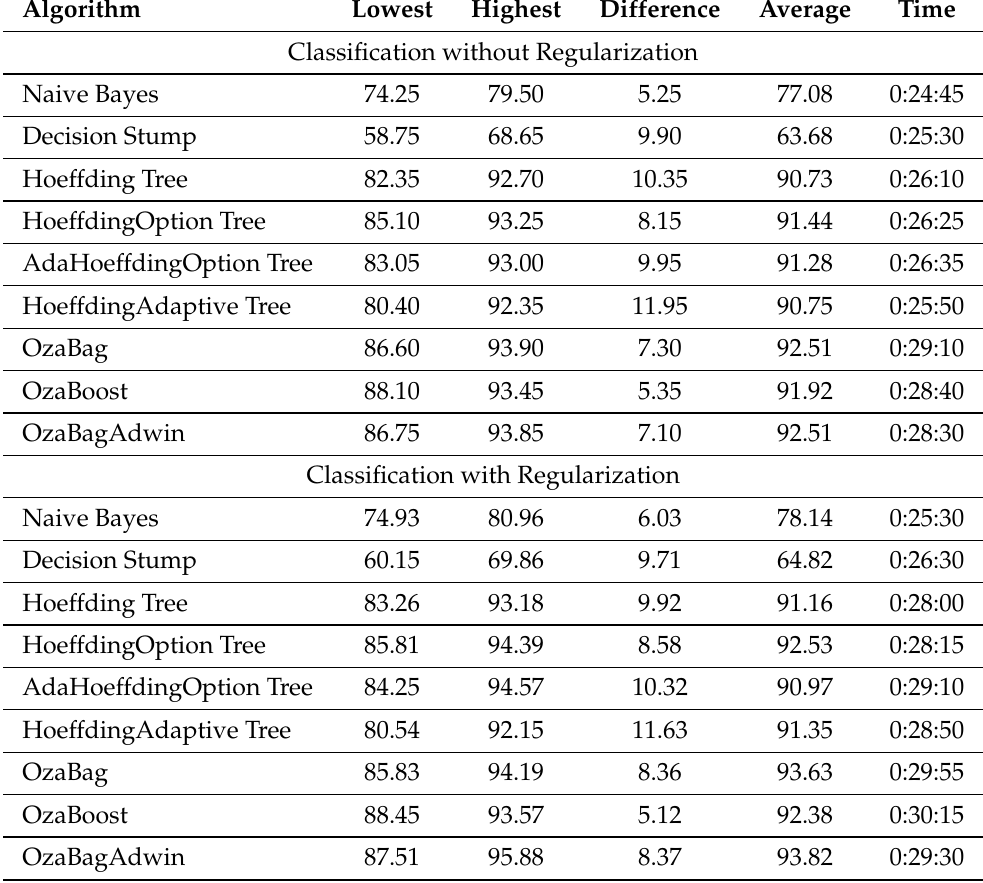
Table 4. Lowest, highest and average accuracy percentages of weather classification for dataset =